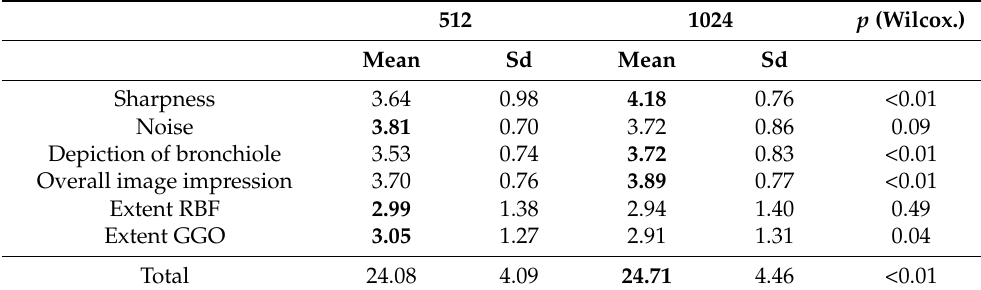
Table 4. Score of the two matrices in the subcategories and in total.